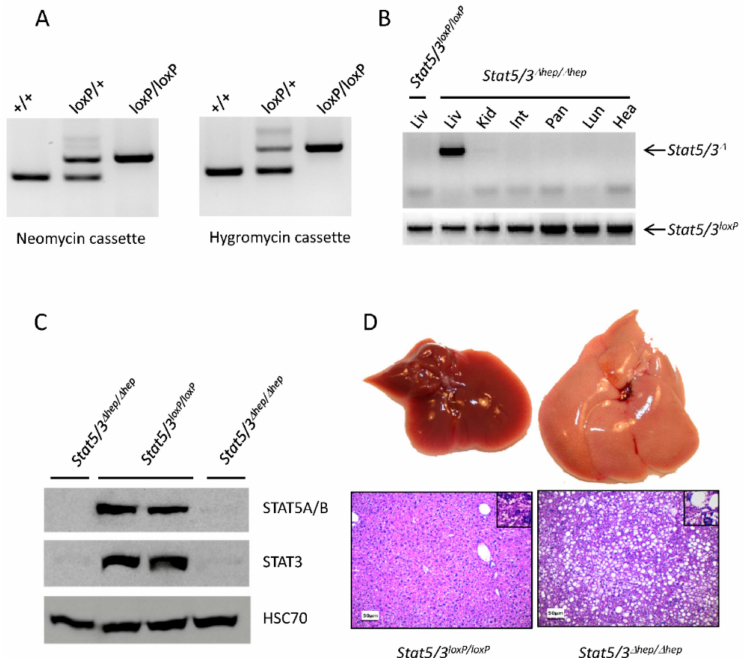
Figure 3. Validation of Stat5 / 3 loxP / loxP mice. ( A ) PCR analysis of tail DNA using the primers P9 / P11 / P12 and P10 / P13 / P14 located in the region of the neomycin and hygromycin cassettes, respectively, showing the expected genotypes. ( B ) PCR analysis of genomic DNA extracted from di ff erent tissues revealed that the Stat5a / b and Stat3 loci are deleted solely in the liver of Stat5 / 3 ∆ hep / ∆ hep mice (Liv: liver; Kid: kidney; Int: small intestine; Pan: pancreas; Lun: Lung; Hea: heart). ( C ) Western blot analysis using liver lysates from Stat5 / 3 loxP / loxP and Stat5 / 3 ∆ hep / ∆ hep mice shows reduced levels of STAT5A / B and STAT3 protein in the livers of Stat5 / 3 ∆ hep / ∆ hep mice (HSC70: Heat Shock 70 kDa protein, loading control). Details can be found in Figure S2. ( D ) Stat5 / 3 ∆ hep / ∆ hep mice develop liver steatosis. Upper pictures: representative macroscopic liver images of control and Stat5 / 3 ∆ hep / ∆ hep mice. Lower pictures: representative liver sections from 8-week-old control and Stat5 / 3 ∆ hep / ∆ hep mice ( n = 3) stained with hematoxylin and eosin (HE), scale bar: 50 µ